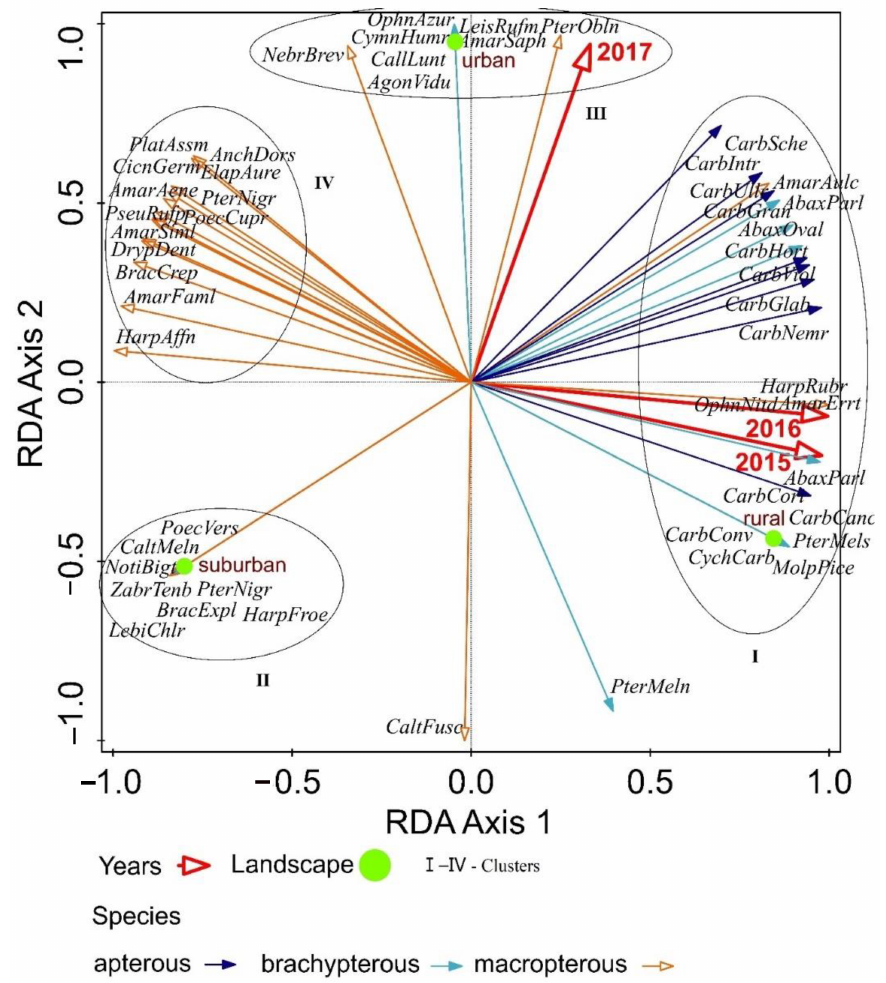
Figure 1. Redundancy analysis (RDA) of species based on EV and flight ability, during the years